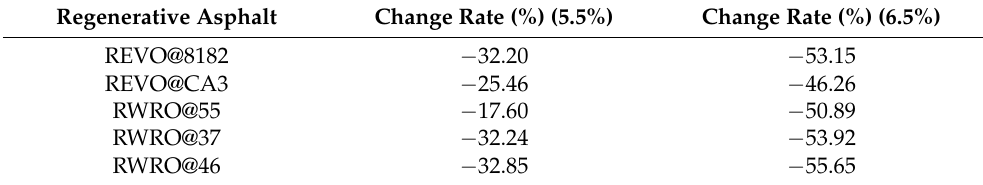
Figure 11. Fatigue life of rejuvenated asphalt under different loading level. Table 11. Fatigue life change rate at different loading levels.